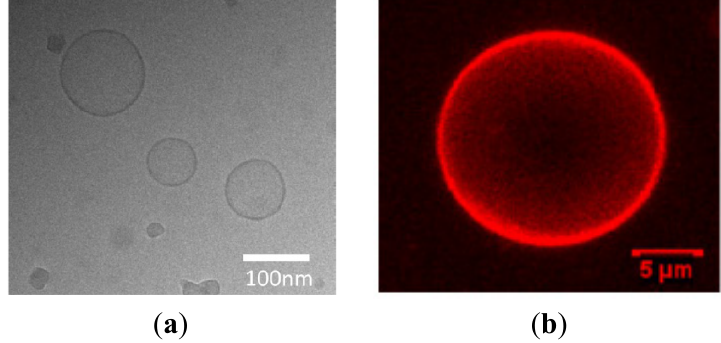
Figure 7. ( a ) Cryo-TEM image of binary vesicles consisting of a 1:1 mixture of an amphiphilic β-CD and lipids (DOPC/DOPE/Chol 50/25/25 mol%); ( b ) 3D reconstructed confocal laser scanning microscopy (CLSM) image of a giant unilamellar vesicle prepared from a lipid film that contains 50 mol% amphiphilic cyclodextrin (CD) (CD/DOPC/DOPE/Chol 50/25/12.5/12.5 mol%) [28]. Reprinted with permission from [28]. Copyright 2013, American Chemical